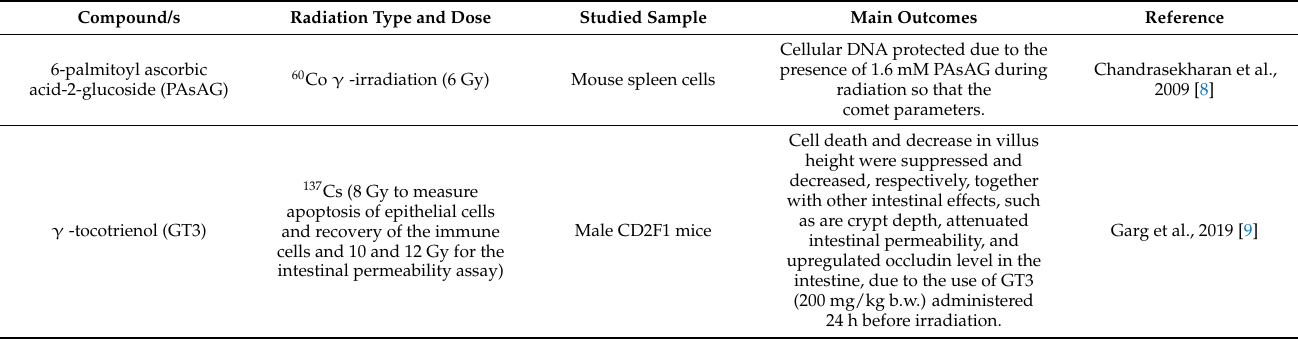
Table 1. Ex vivo studies about radioprotective effect of